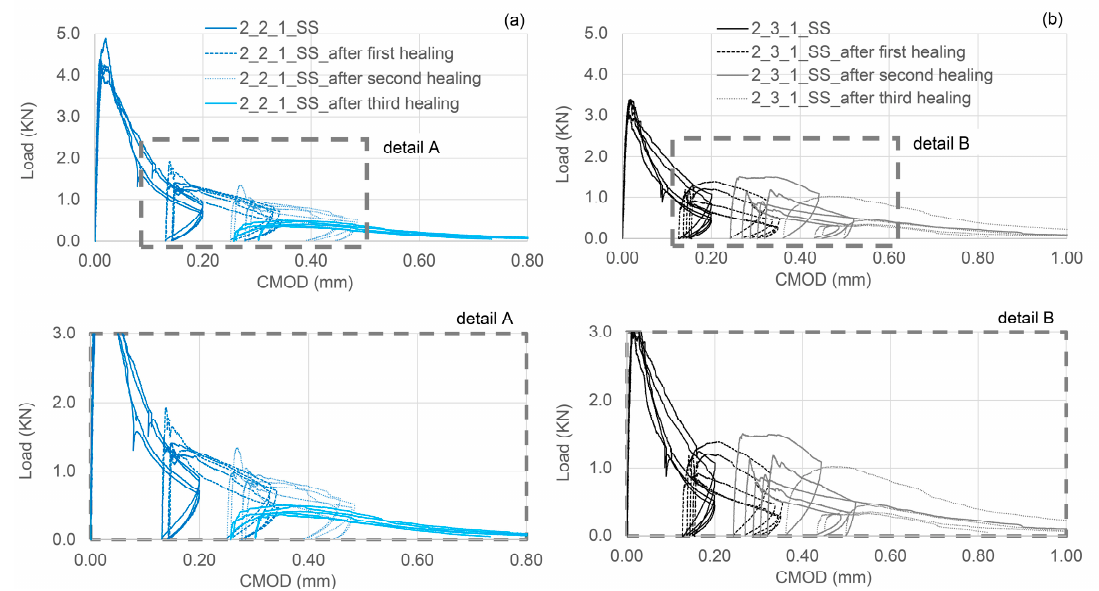
Figure 12. Flexural load-CMOD responses for 3 damage-healing cycles for specimens containing ( a ) 2 TETs filled with SS; ( b ) 3 TETs filled with SS.